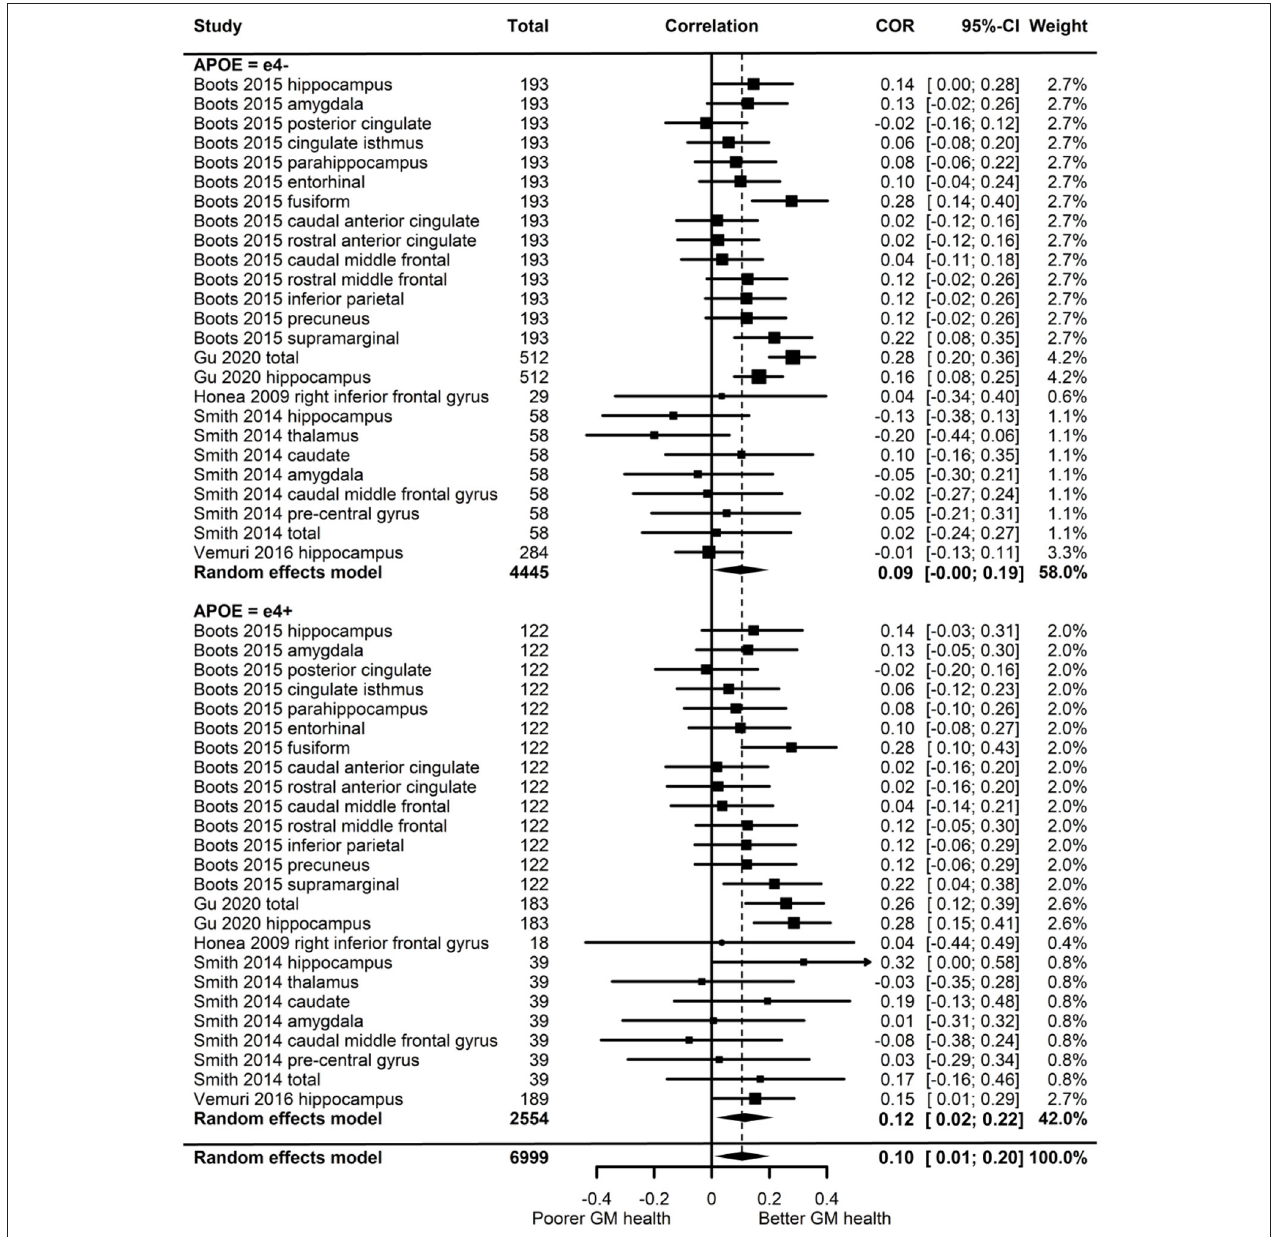
FIGURE 5 | Forest plot indicating the association between physical activity and GM with carrier (e4 + ) and non-carrier (e4–) subgroups. Subgroup moderation test indicated no significant difference between APOE groups ( p =